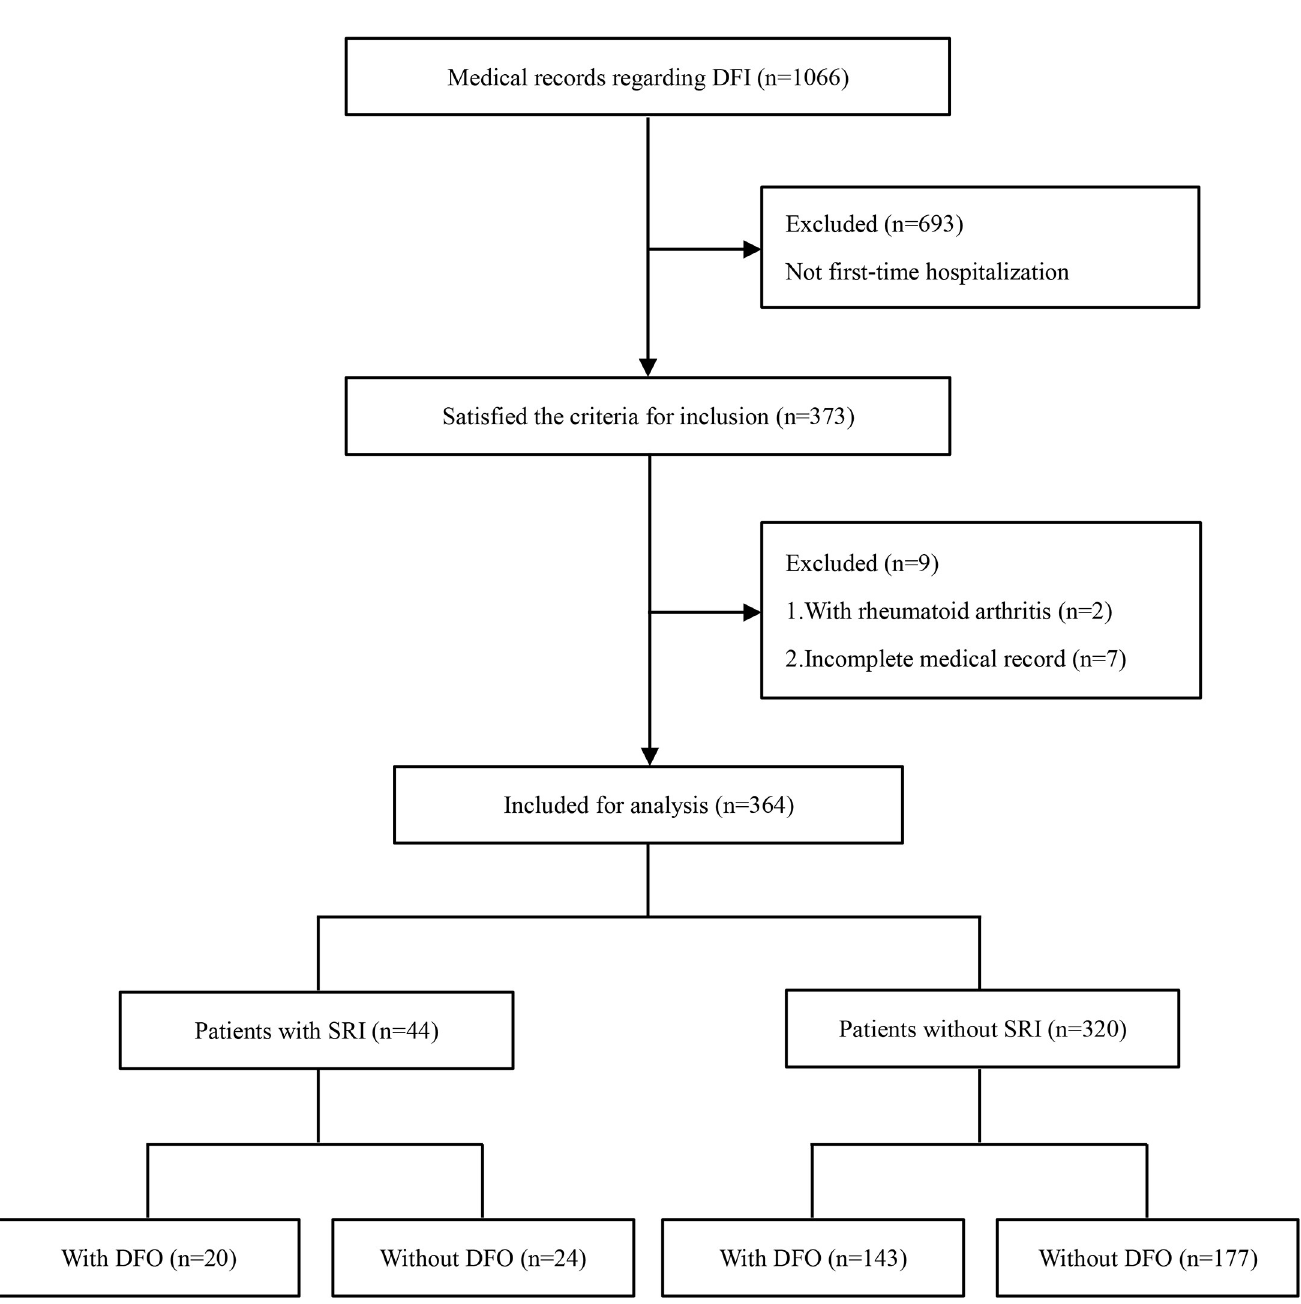
Fig 1. The flow chart of the study. DFI, diabetic foot infection; DFO, diabetic foot osteomyelitis; SRI, severe renal impairment.